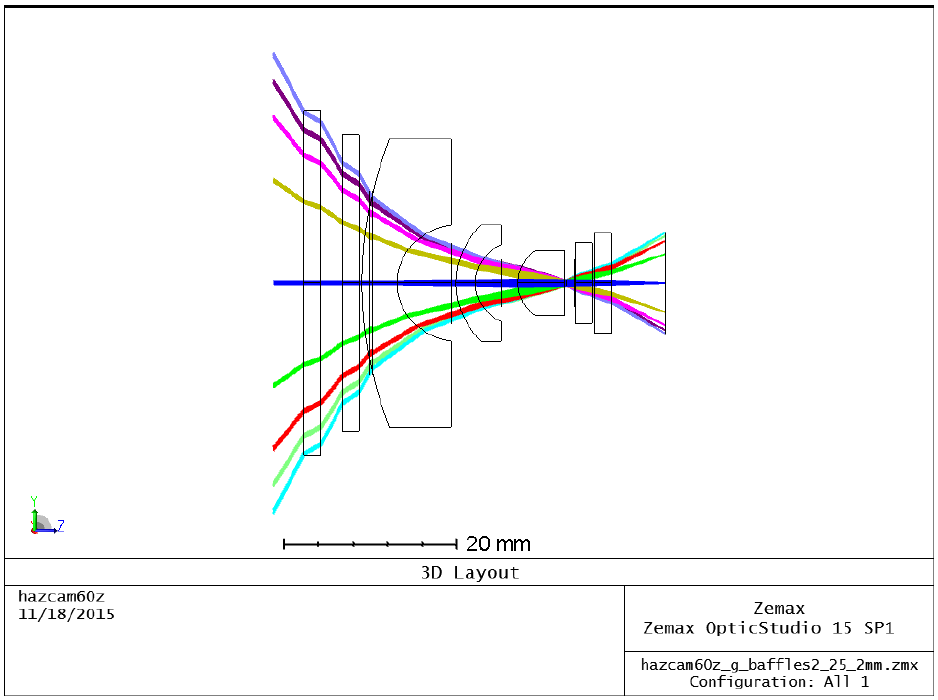
Figure 12. Raytrace of improved RDS-SkyCam optic through the RDS top cover sapphire window and new absorbing ND1.1 first element.